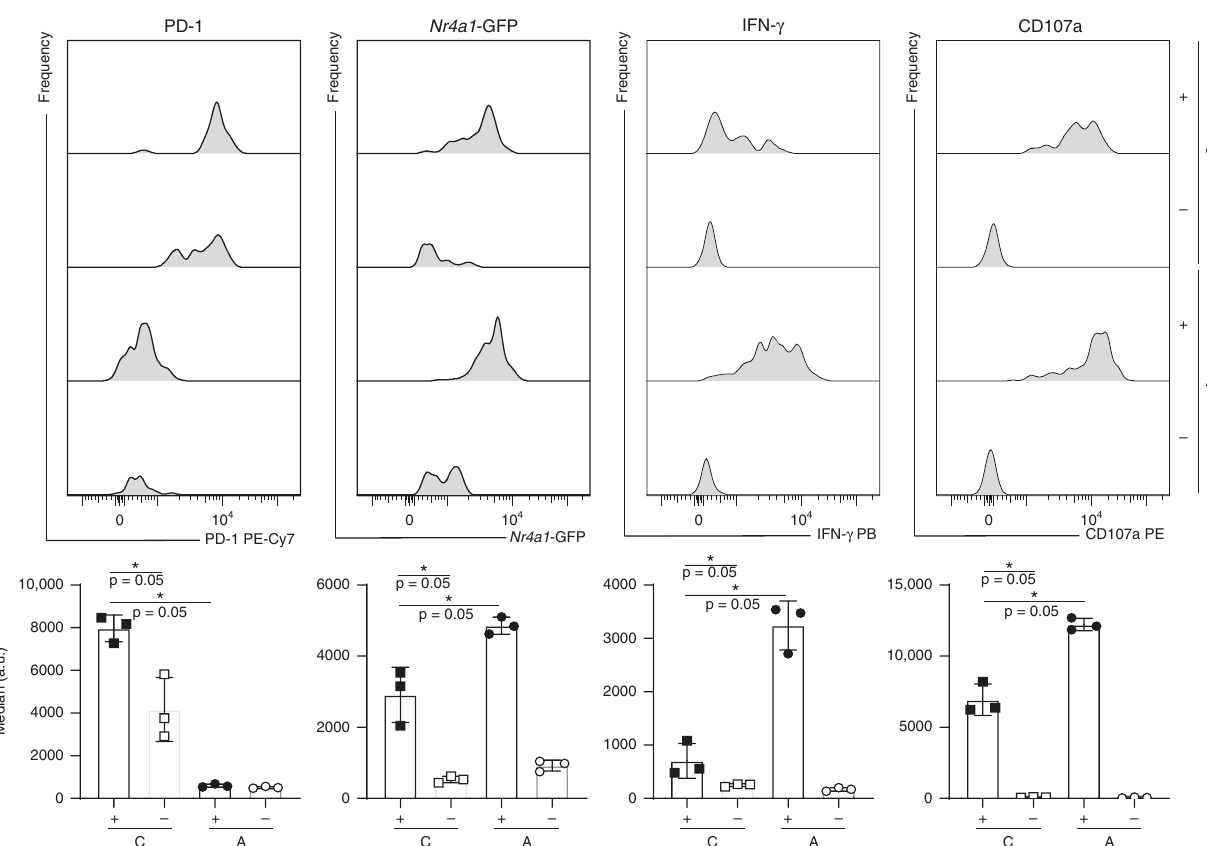
Fig. 3 In vitro restimulation of sorted P14 cells of acutely or chronically infected mice. CD45.1 + P14- Nr4a1 -GFP cells were adoptively transferred into CD45.2 + mice 1 day prior infection with a high (2×10 6 ffu for chronic (C) infection) or low (200ffu to induce an acute (A) infection) dose of LCMV clone 13. Three weeks post infection, P14 cells were sorted from the spleen and stimulated in vitro for 6h with plate-bound antibodies. Various markers were quanti fi ed (bar plots represent average of medians±SD) and a representative histogram per group ( n = 3 mice) is shown for cells that responded (CD107a + ), denoted by plus signs, and cells that did not (CD107a − ), denoted by minus signs. Asterisk (*) represents p -value = 0.05 (Mann – Whitney one-tailed-test without adjustment for multiple comparisons). Each dot represents an individual mouse. One of two experiments is shown. See also Supplementary Fig. 2. Source data are provided as a Source Data